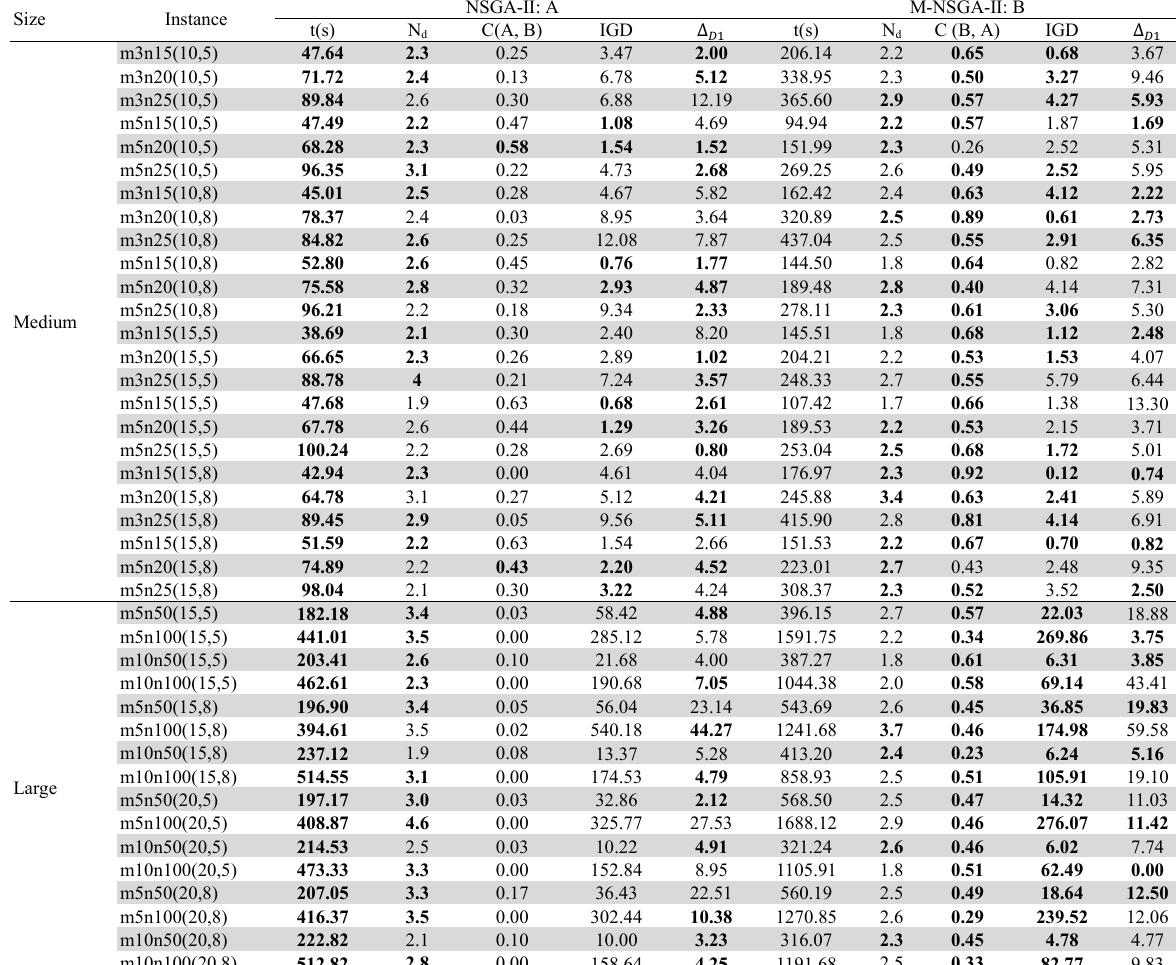
Performance results for different algorithms (medium- and large-scale problem instances) Size